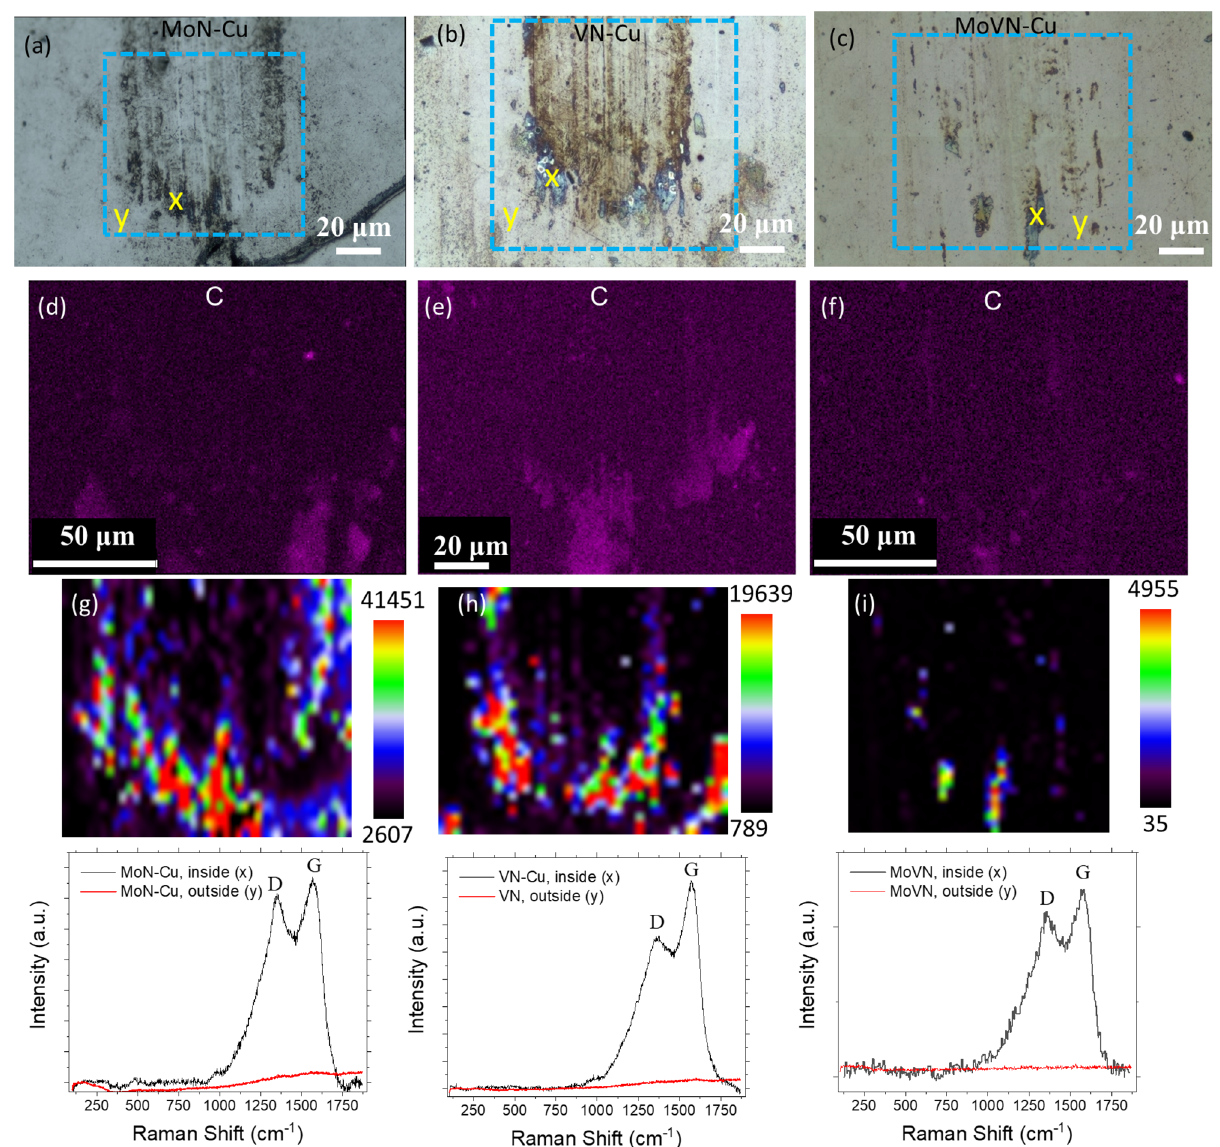
Figure 3. Optical micrographs of the wear tracks, C elemental EDS mapping, and the corresponding Raman mapping for ( a , d , g ) MoN-Cu, ( b , e , h ) VN-Cu, and ( c , f , i ) MoVN-Cu films, respectively. The 2D-Raman analysis is supported by the Raman spectrum collection for two selected spots, inside and outside of the wear track. The tribology tests were performed in decane at 1 N load and 50